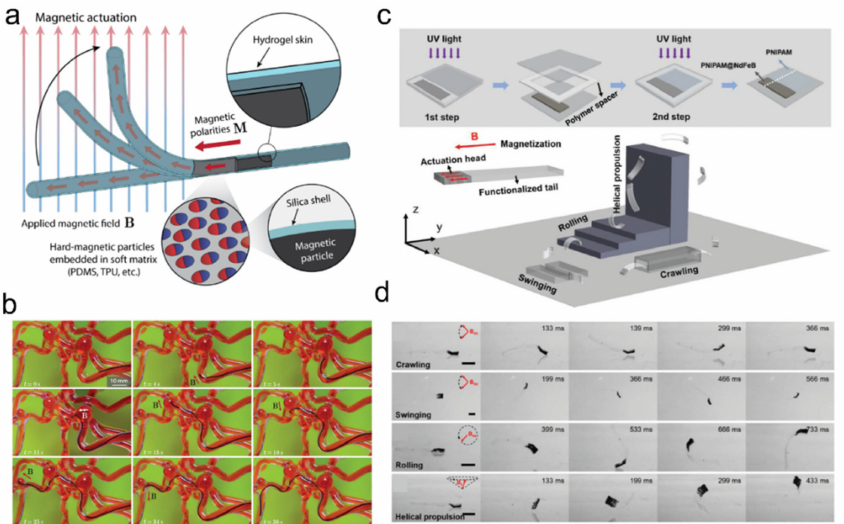
Figure 13. Magnetic particle-laden hydrogels as soft robots. ( a , b ) Schematic ( a ) and demonstration ( b ) of hydrogel-coated ferromagnetic polymer soft robots; adapted with permission from [168]. Copyright 2019 AAAS. ( c , d ) Schematic ( c ) and locomotion demonstration ( d ) of soft untethered millirobot (iRobot). iRobot is capable of crawling, swinging, rolling, and helical propulsion in water at room temperature using oscillating magnetic field (~10 mT); adapted with permission from [169]. Copyright 2020